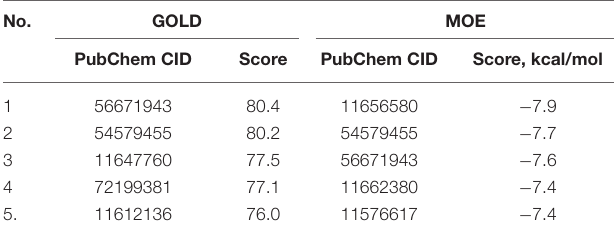
TABLE 4 | The PubChem CID and the scores for the top five out of 26 crizotinib derivatives according to the docking results performed by the GOLD and MOE